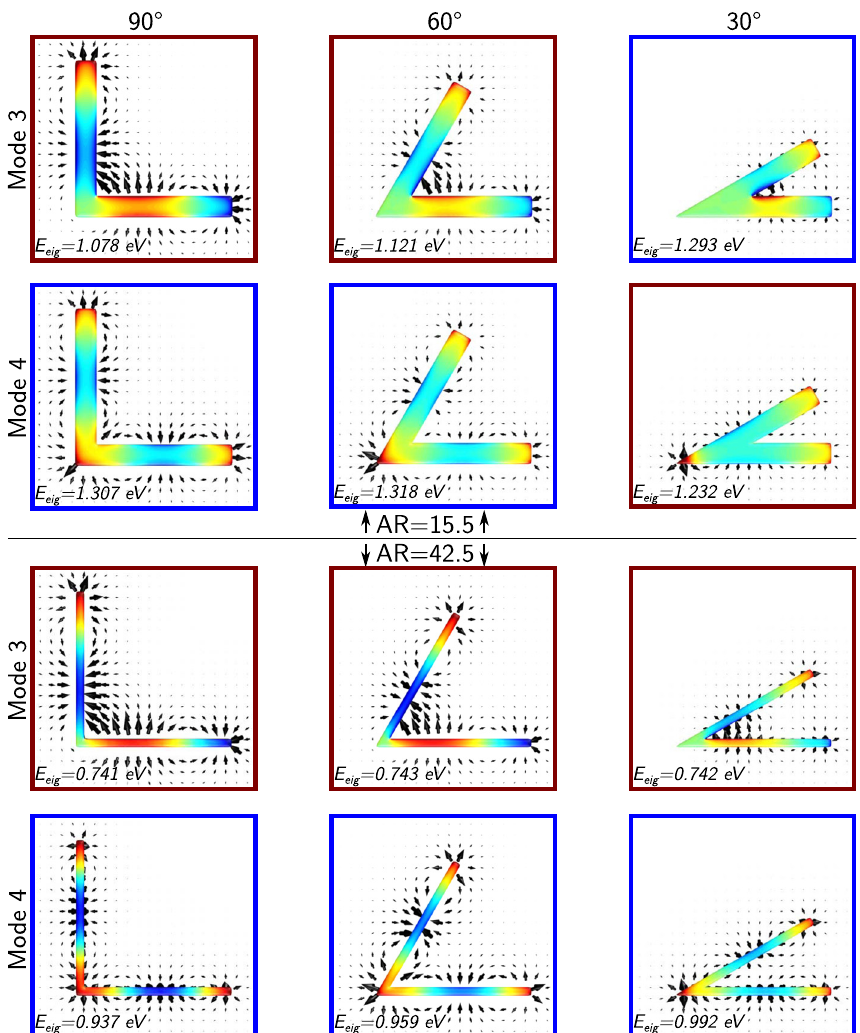
Figure 5: Evolution of eigenmodes 3 and 4 showing the changes in eigenenergy, charge distributions, and electric field distributions of the modes at different bending angles for NWs with aspect ratios of 15.5 (top two rows) and 42.5 (bottom two rows). The red boxes indicate the lower energy mode and the blue boxes the higher energy mode, highlighting the energy crossing of modes 3 and 4 of the NW with 15.5 aspect